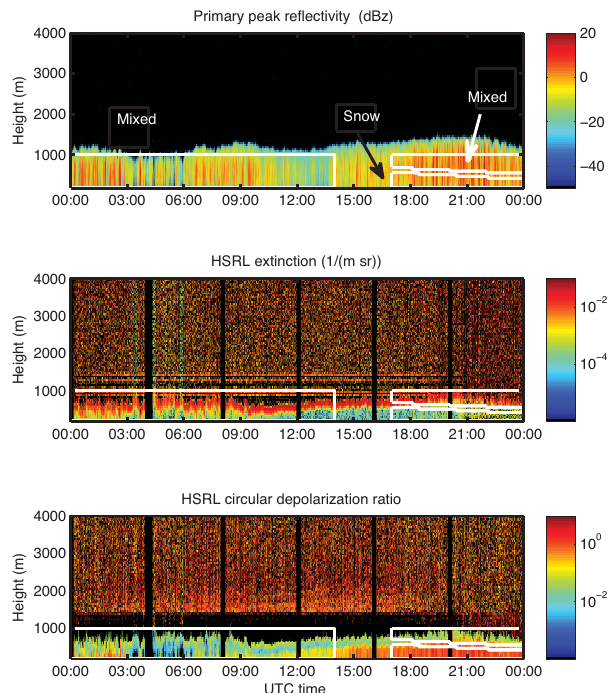
Figure 5. On 9 October 2004, vertical profile data from MMCR re- flectivity, HSRL extinction, and HSRL circular depolarization ratio. Periods identified as snow, and mixed phase are outlined in